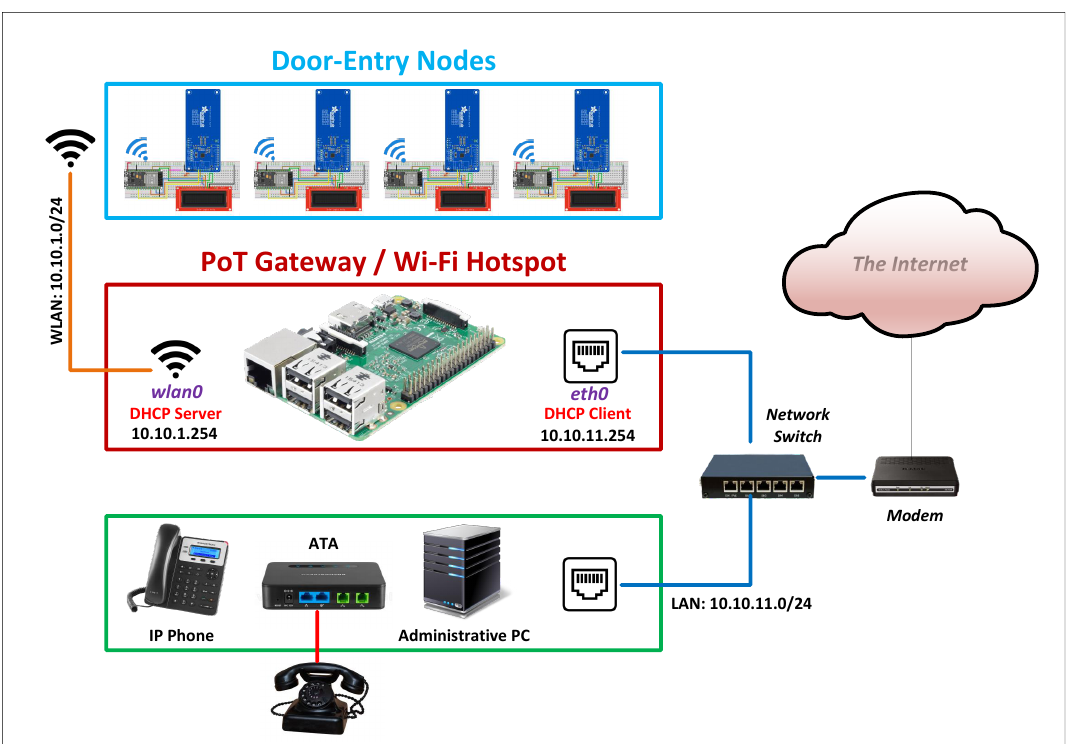
Figure 3. Overview of the PoT gateway as a Wi-Fi access point to the door-entry